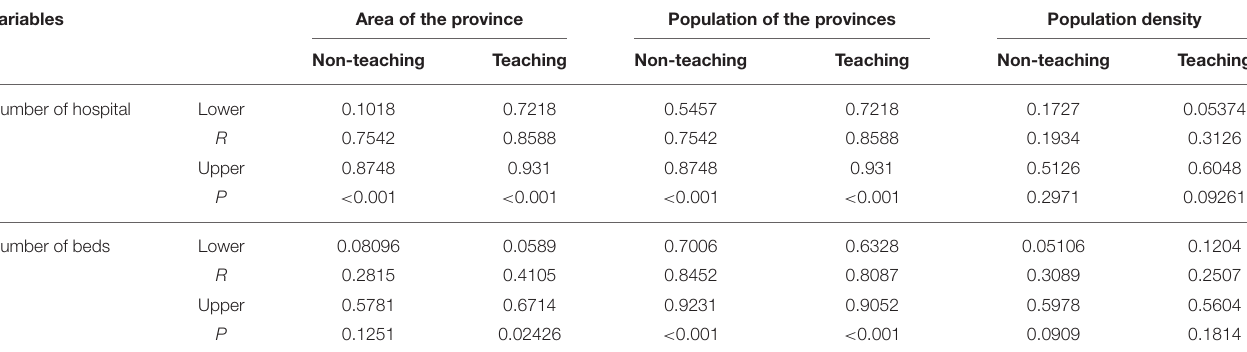
TABLE 6 | The relationship between number of hospitals/number of beds with contextual factors.